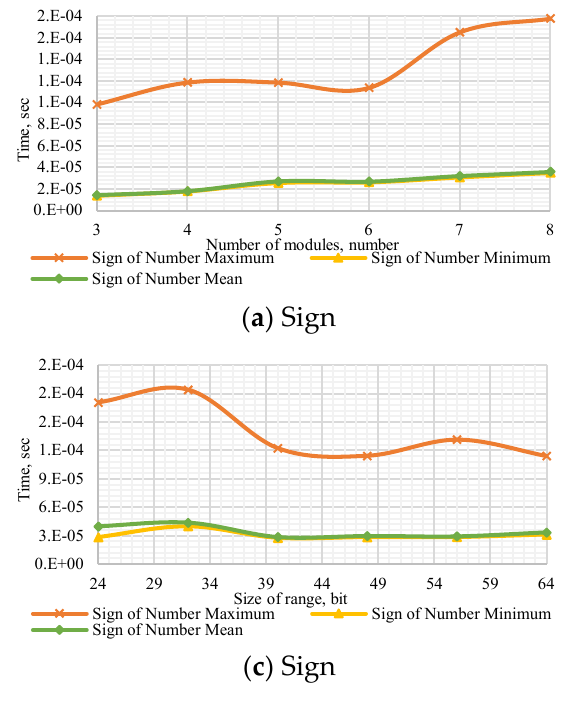
dynamic number of modules (cid:1868) , ( b ) compare dynamic numbers of modules (cid:1868) , ( c ) determine the